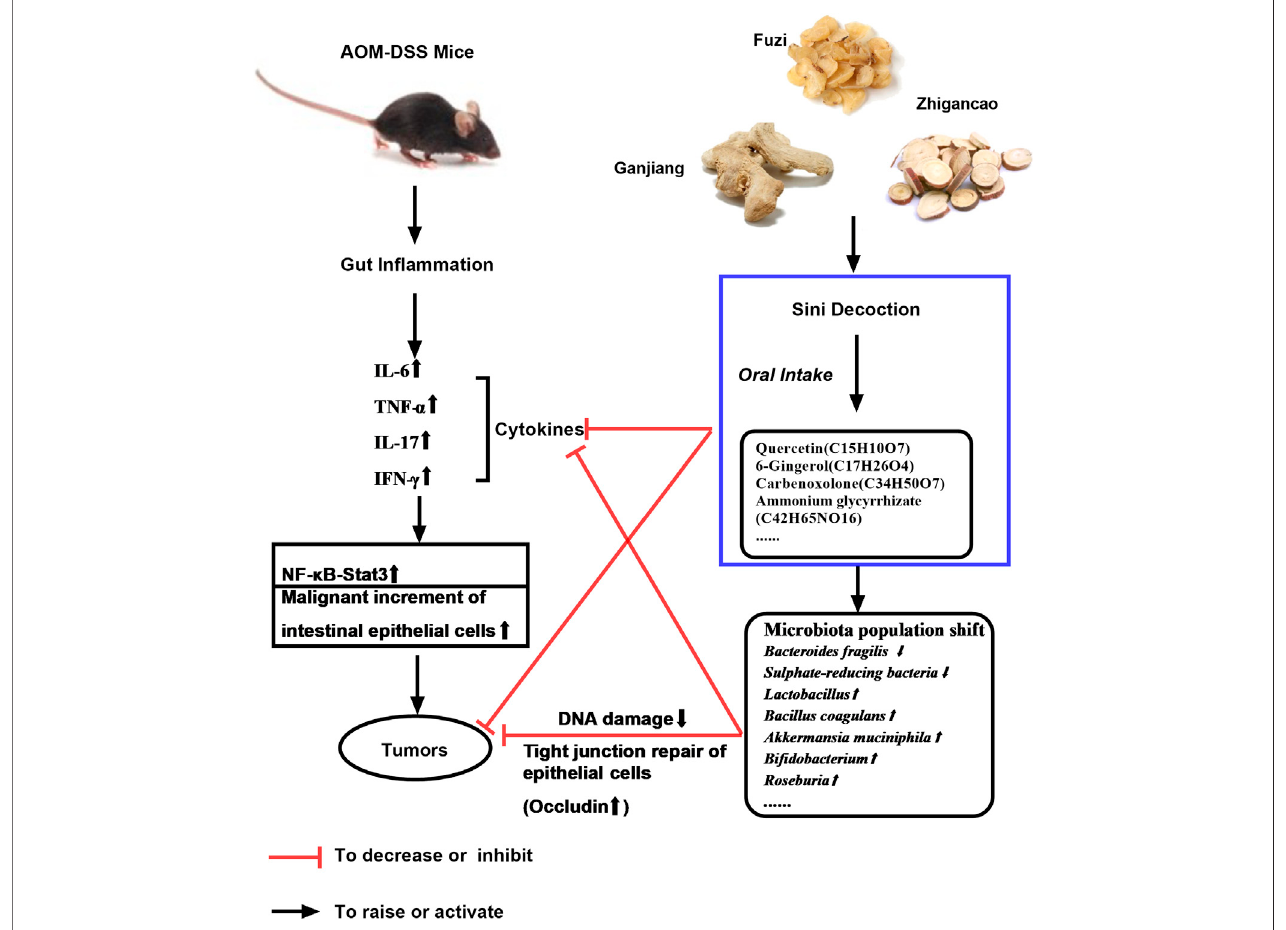
FIGURE 9 | Schematic diagram of SND on AOM/DSS-induced colon